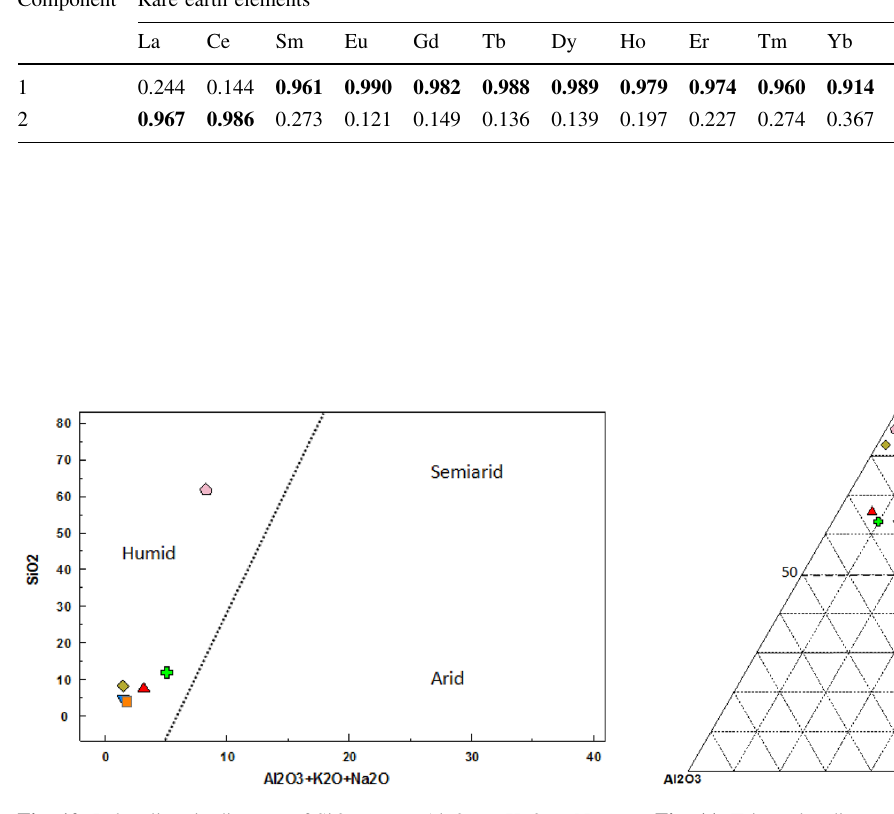
Variance Cumulative values (%) (%)